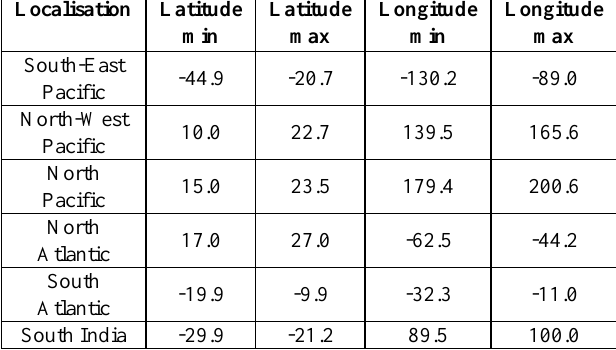
Table 3: Position of the ocean calibration sites.